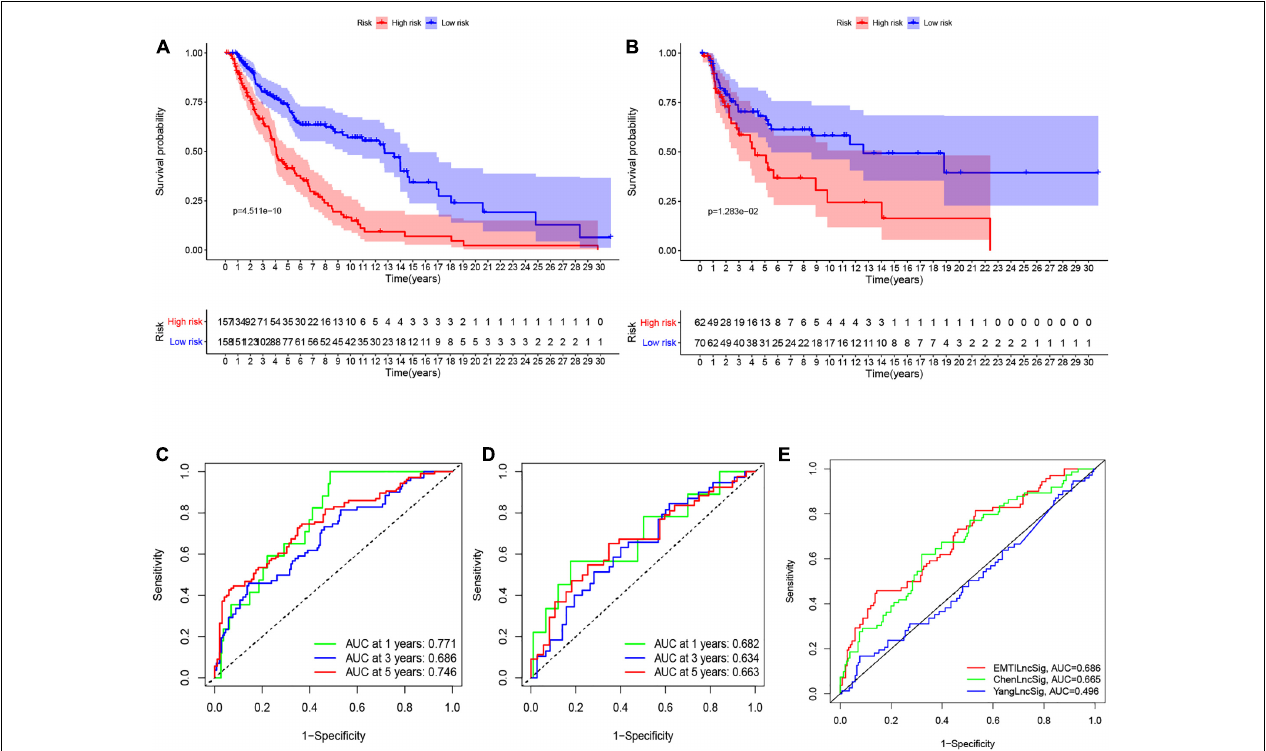
FIGURE 2 | K–M survival analysis (A,B) , ROC curves (C,D) at 1-, 3-, and 5-years post diagnosis of immune-related lncRNA signature in melanoma in training and testing cohort. The ROC curve at 3 years of overall survival for the EMTLncSig, ChenLncSig and YangLncSig (E) .